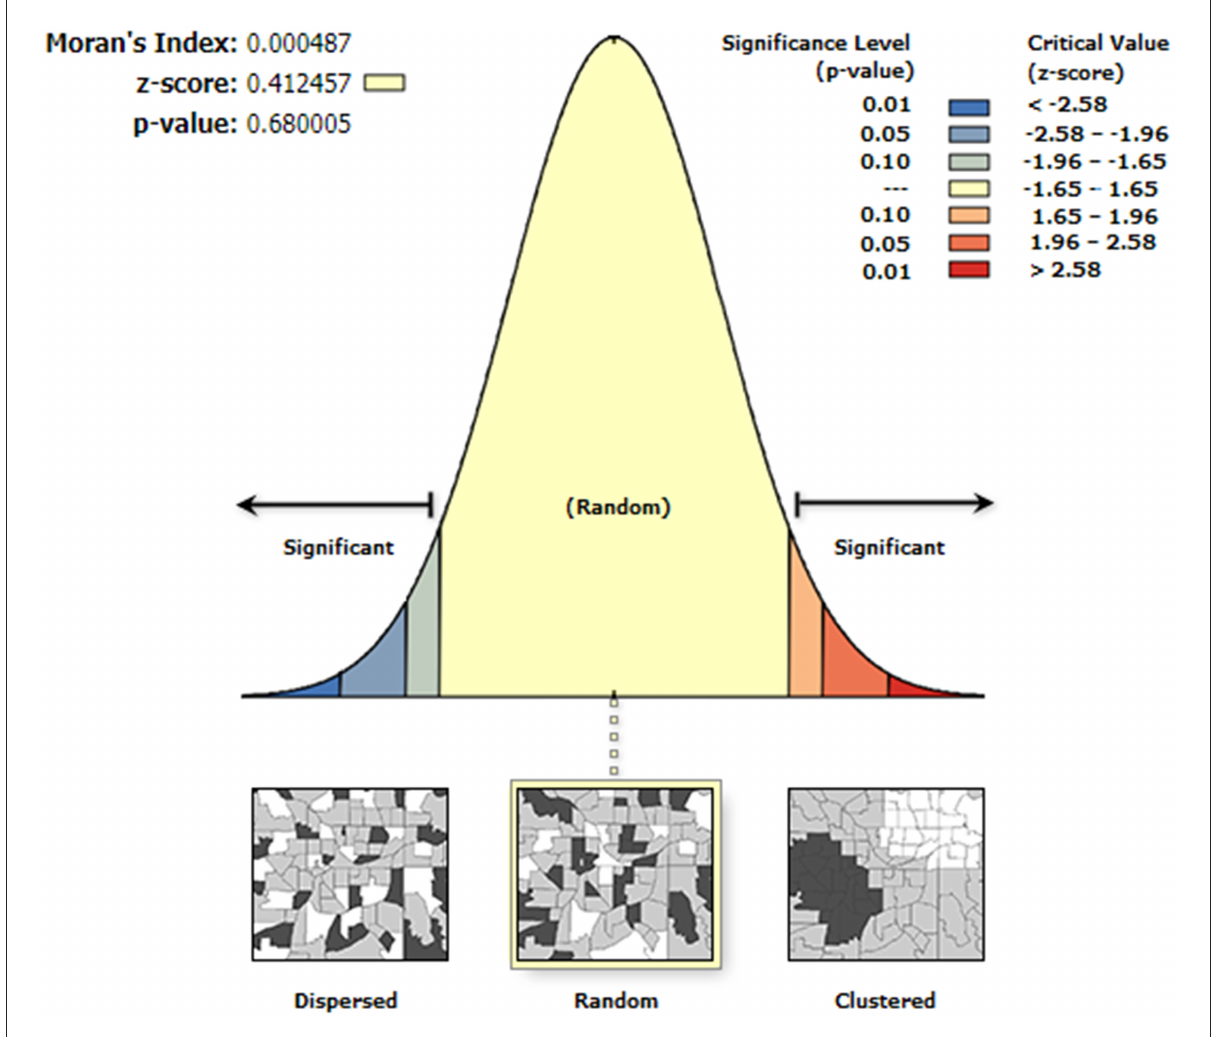
FIGURE5 Global spatial autocorrelation analysis of the hair selenium levels at the county